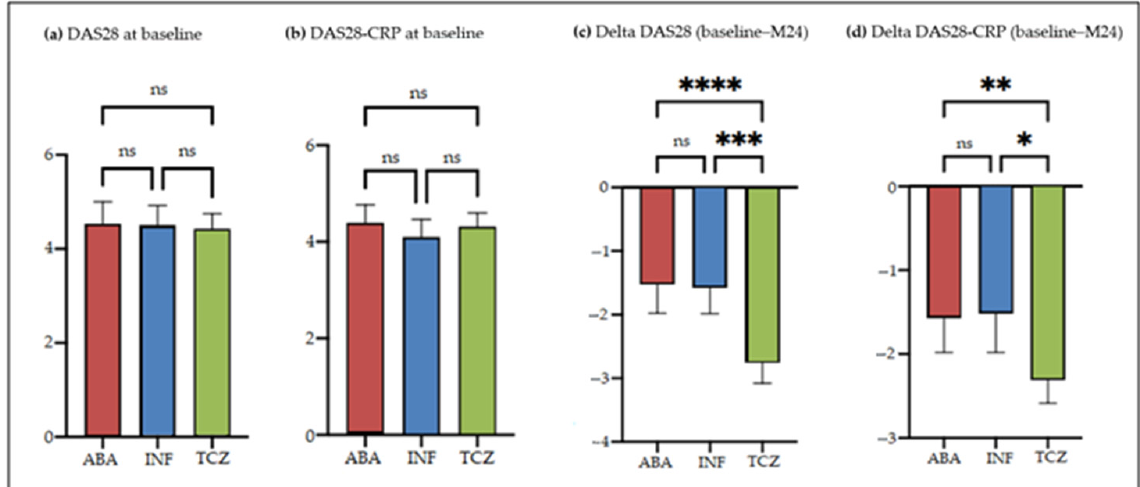
Figure 2. ( a ) Comparison of DAS28 at baseline; ( b ) comparison of DAS28-CRP at baseline, ( c ) DAS28 changes between baseline and M24 of treatment with infliximab (INF), abatacept (ABA), or tocilizumab (TCZ); ( d ) DAS28-CRP changes between baseline and M24 of treatment with INF, ABA, or TCZ. ns: non-significant; *: p = 0.012; **: p = 0.006; ***: p = 0.005; ****: p < 0.001.